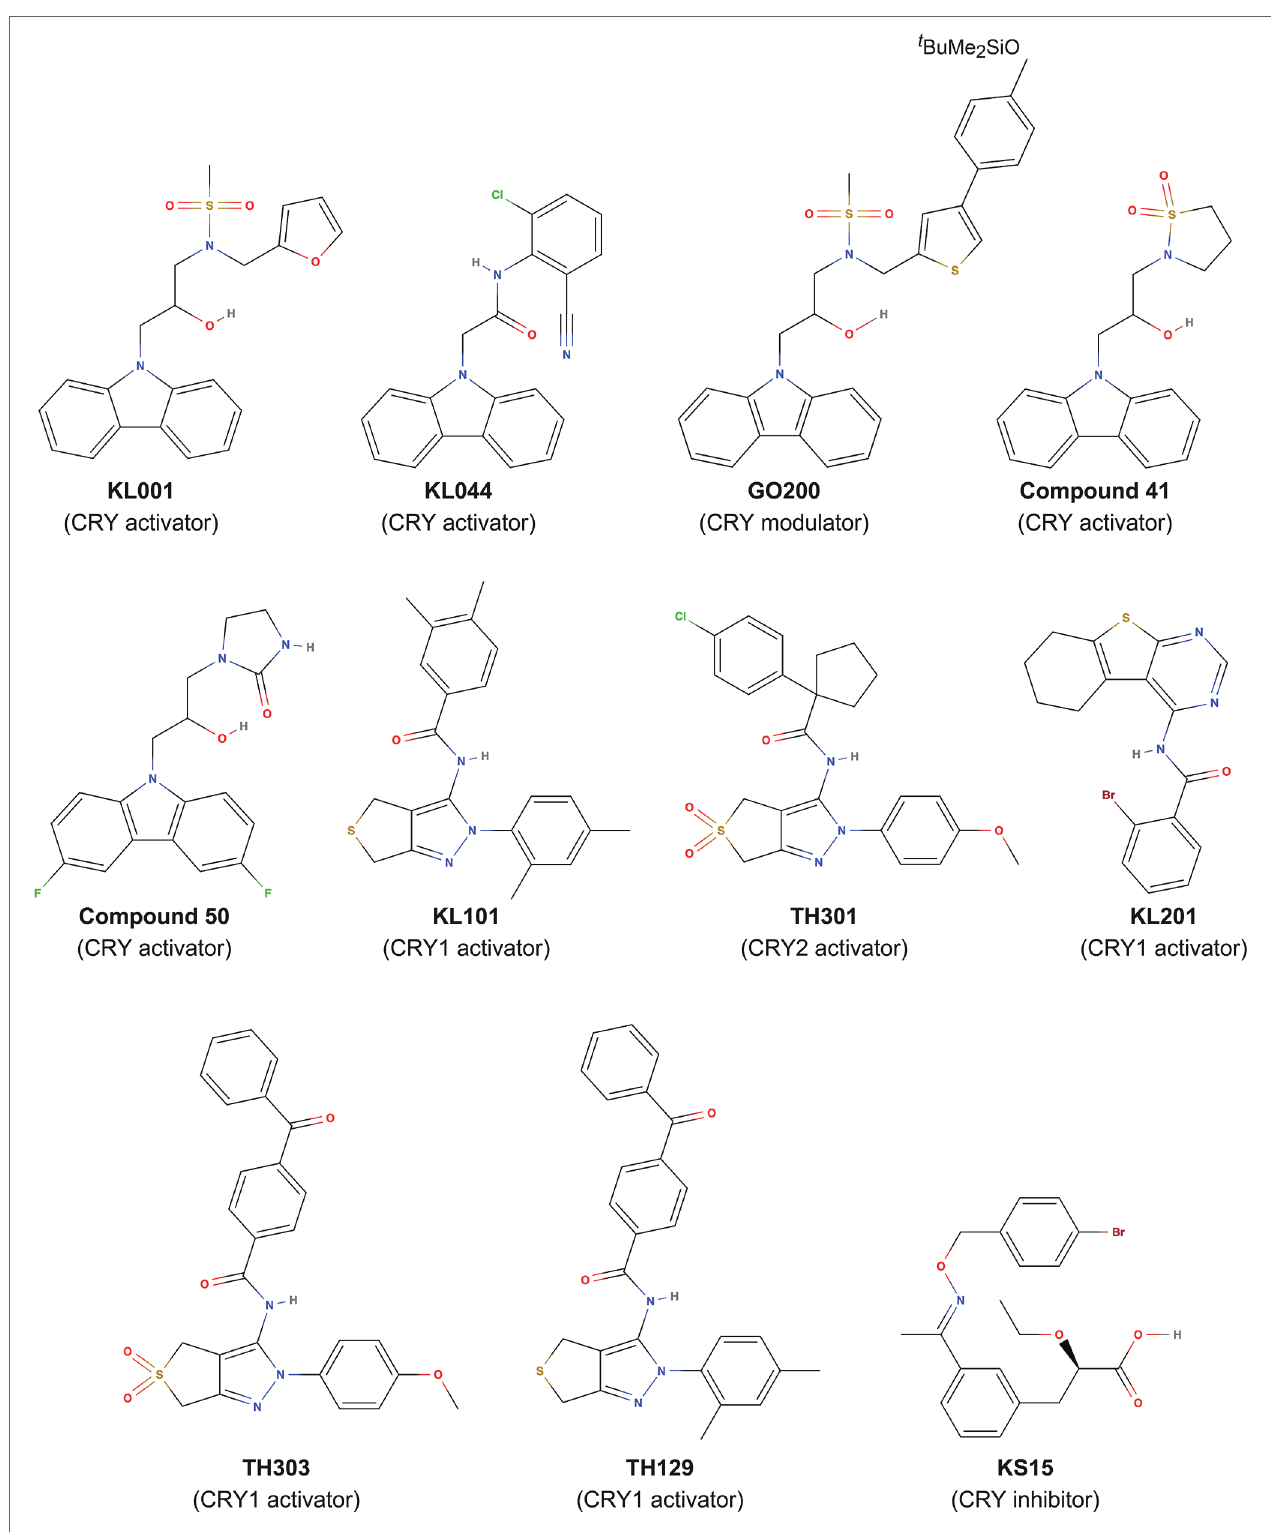
FIGURE 1 | Small-molecule compounds that target CRY